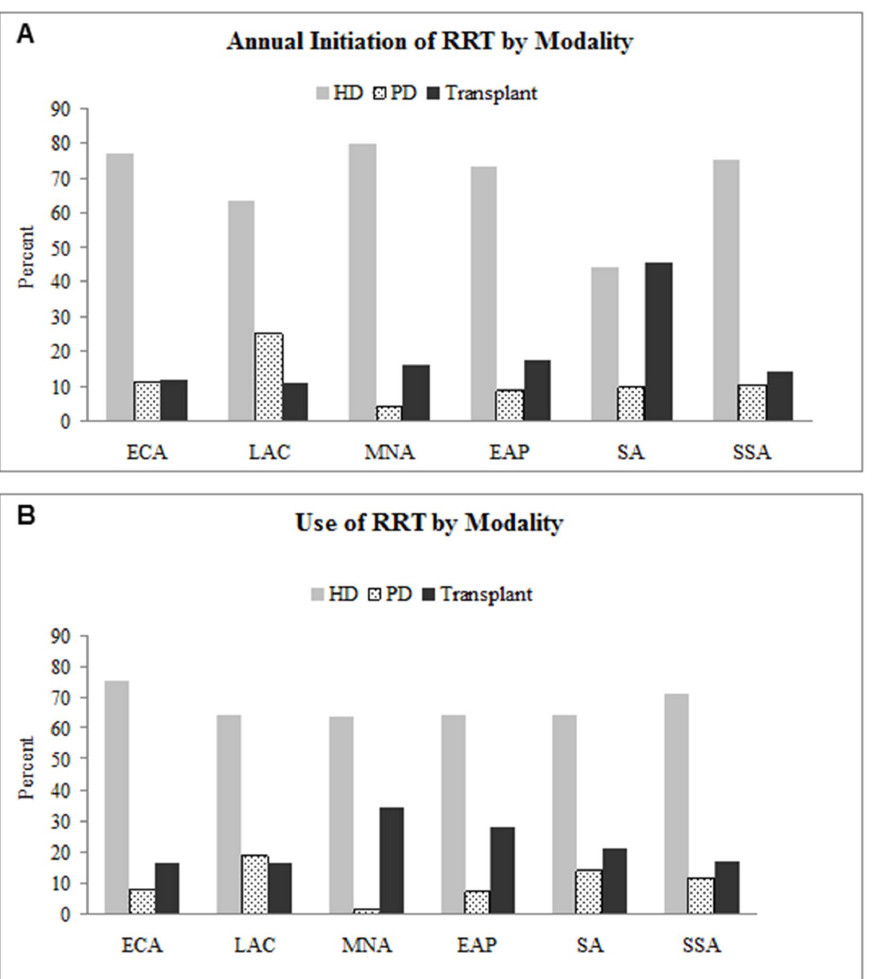
Figure 3. Annual initiation of RRT and use of RRT by modality. Hemodialysis is the most commonly used therapy within developing regions. Transplants are relatively more commonly used and initiated therapies in MNA and SA regions. Peritoneal dialysis is relatively more commonly used and initiated in LAC. Abbreviations: RRT-Renal replacement therapy, HD-Hemodialysis, PD-Peritoneal dialysis, ECA-Eastern Europe and Central Asia, LAC-Latin America and Caribbean, MNA-Middle East and North Africa, EAP-East Asia and Pacific, SA-South Asia and SSA-Sub-saharan Africa.